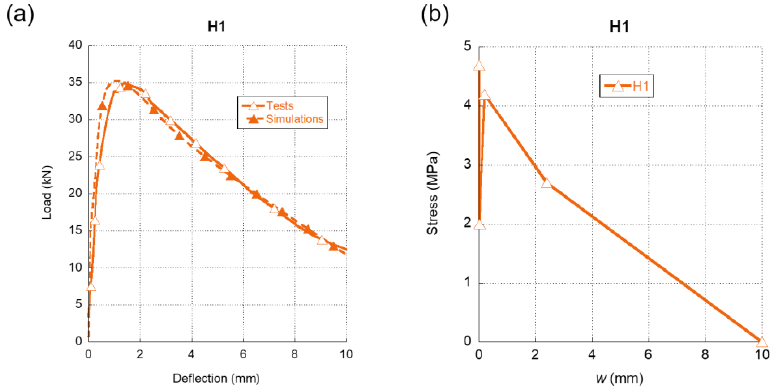
Figure 7. ( a ) Comparison of the average experimental results obtained in the fracture tests of H1 and the numerical simulation. ( b ) Softening function used in the simulation shown in ( a